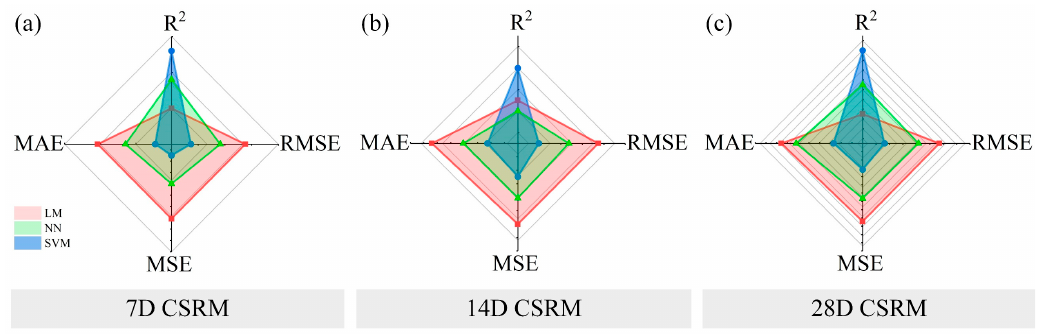
Figure 19. Performances of FL, BL, and IST predicted models. ( a ) FL ( b ) BL ( c ) IST.